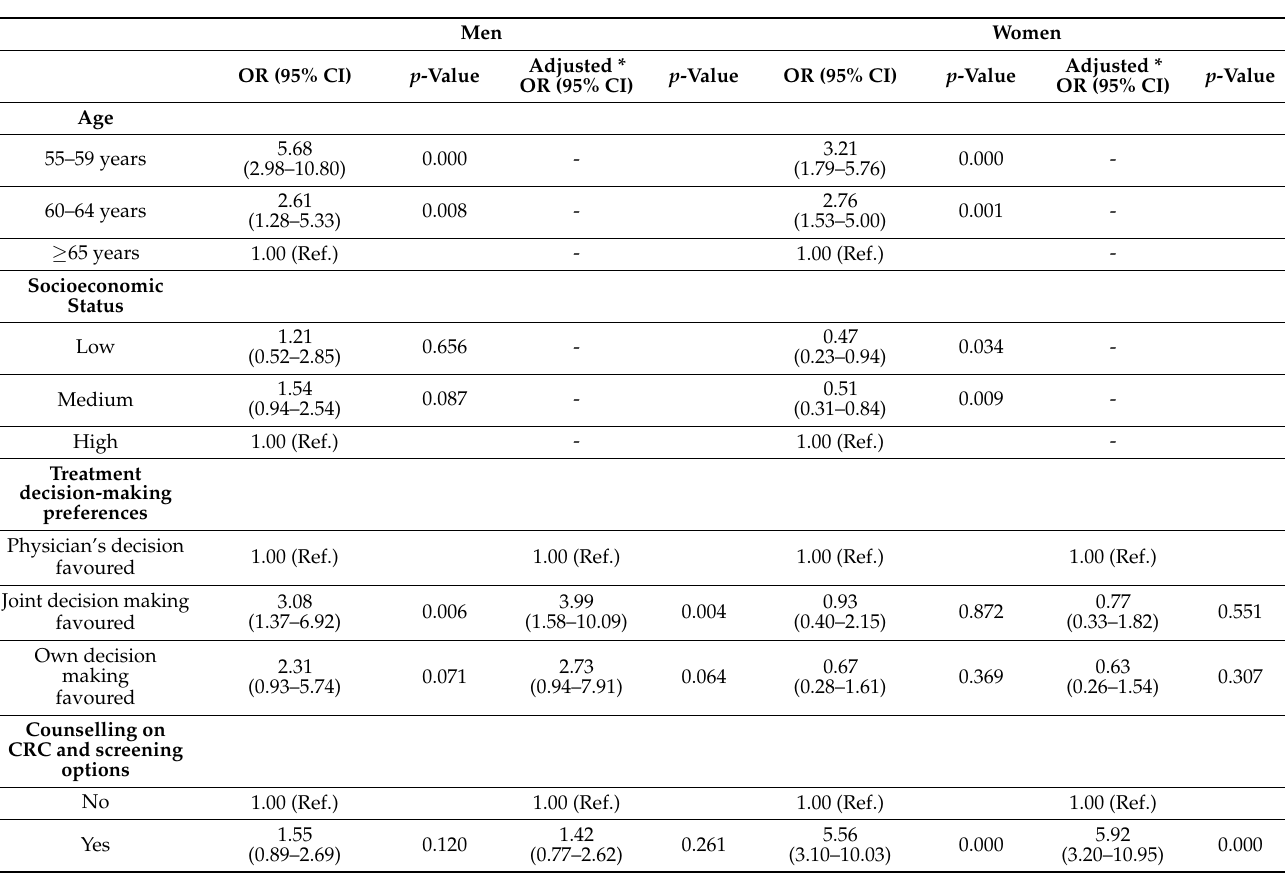
Table 3. Odds ratios of intention to participate in screening colonoscopy by the examined